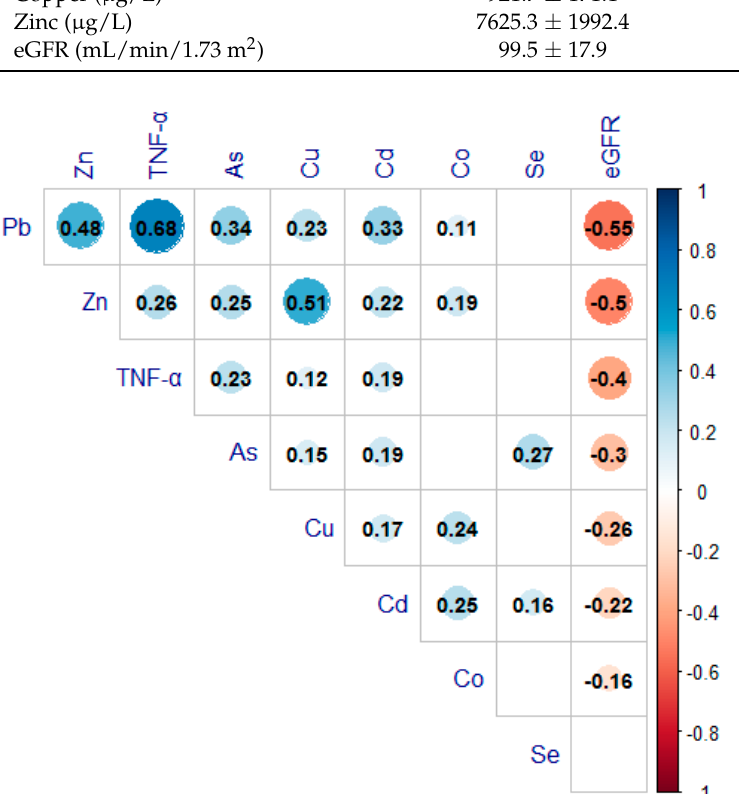
Figure 2. The Pearson correlation analysis between multiple metal concentrations and TNF- α level, and eGFR. (If the p -value was non-significant, the correlation coefficient is not be displayed).